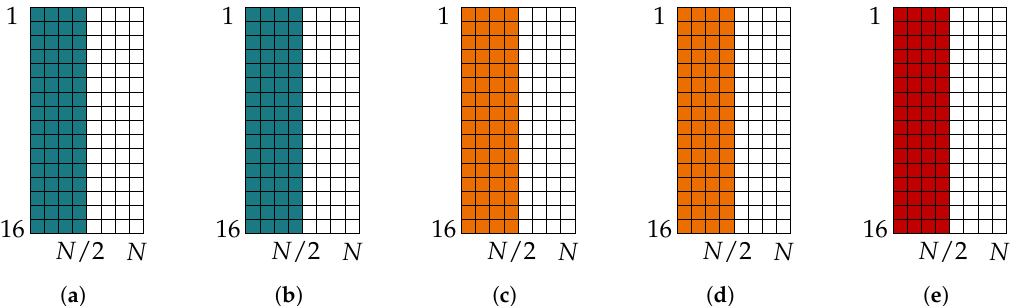
Figure 12. Frozen charts for half-rate polar code with N = 128 and design E b / N 0 = 3 dB, constructed using ( a ) Tal and Vardy’s method with |T | = 512, ( b ) Tal and Vardy’s method with |T | = 16, ( c ) information bottleneck method with |T | = 16, ( d ) information bottleneck method with |T | = 32, and ( e ) Gaussian